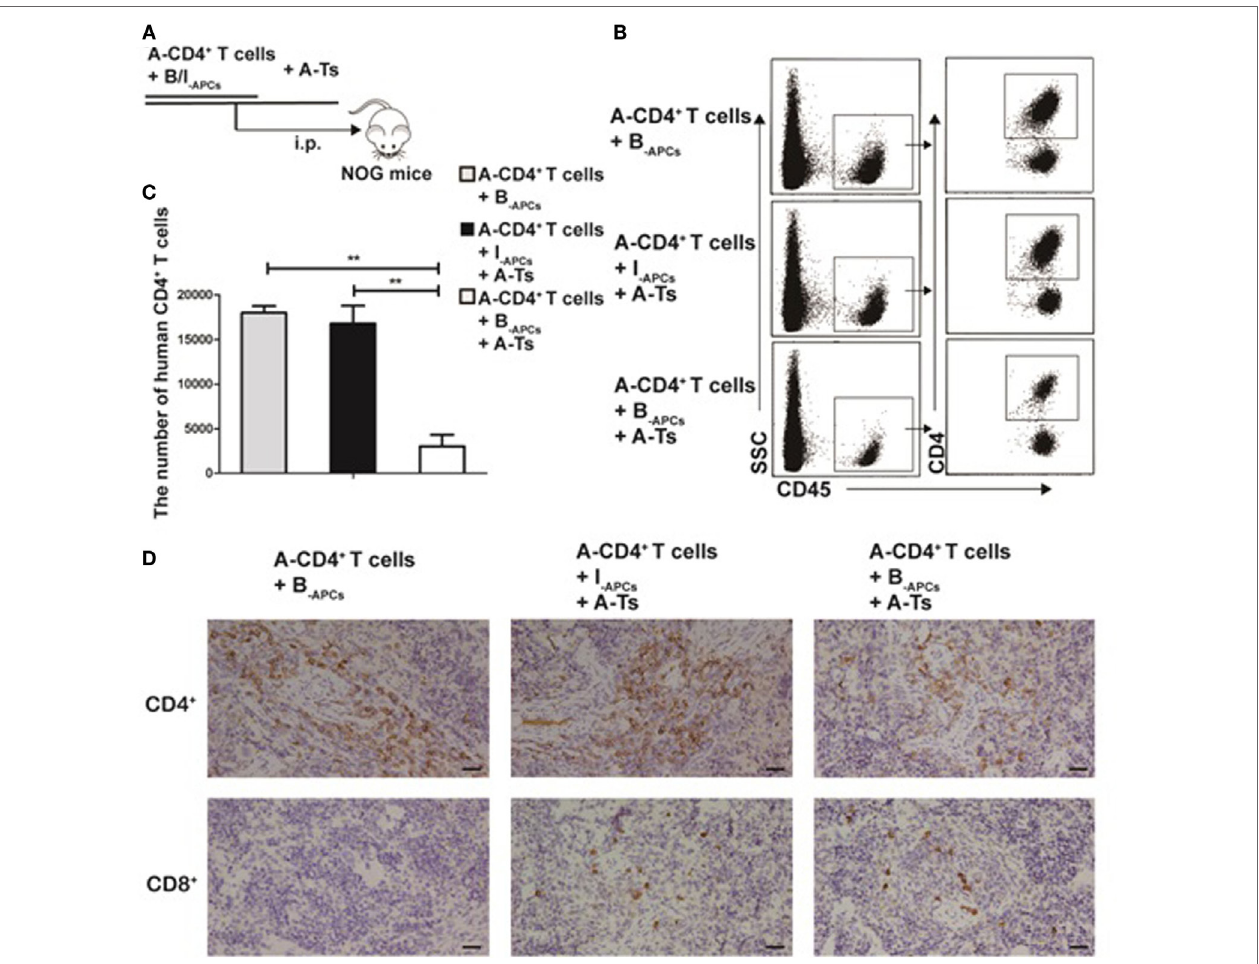
FigUre 4 | CD8 + CD28 − T cells expanded by IL-15 inhibit allospecific CD4 + T cell proliferation in vivo . (a) 4 × 10 6 purified responder CD4 + T cells (R) from donor A and 4 × 10 6 antigen-presenting cells (APCs) from donor B (B -APCs ) or from an indifferent donor I [I -APCs , human leukocyte antigen (HLA)-A, -B, and -DR fully mismatched with donor B] were adoptive transferred into NOG mice via i.p., the in vitro expanded CD8 + CD28 − T cells were added as putative suppressors (S) at S:R ratios of 0.5:1. (b) The mice were sacrificed to get splenic suspension on day 11, human CD45 and CD4 were as gates in flow cytometry to assess CD4 + T cells number. (c) The bar graphs indicate human CD4 + T cell number in mice splenic suspension, which were average value for three independent experiments. (D) Immunohistochemical staining in NOG mouse spleen tissues (magnification, 400 × ) showed human CD4 + T cell (A-CD4 + T cells) and CD8 + T cells (human CD8 + CD28 − T cells, A-Ts). Representative data of three mice in three independent experiments. The bar graphs indicate the means ± SD. * p < 0.05, ** p < 0.01, and *** p <